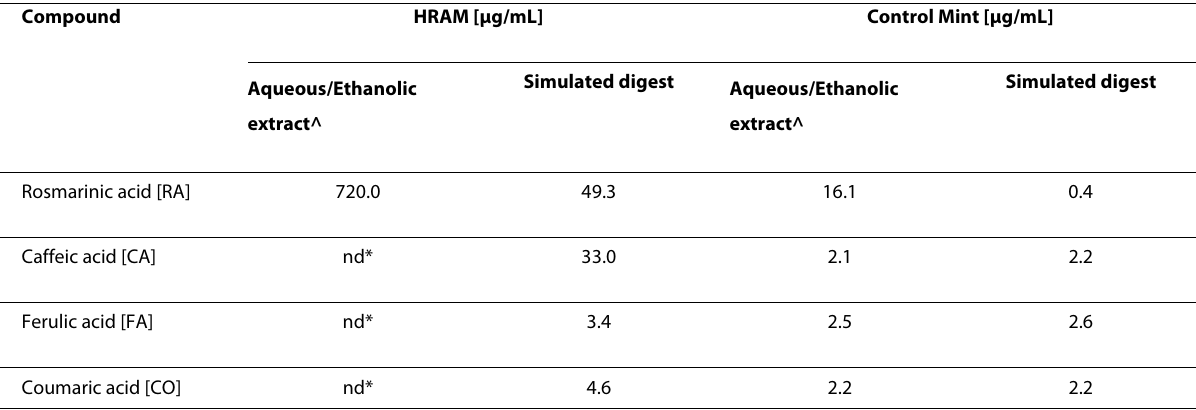
Table 1: Concentrations of metabolites identified in aqueous extract and simulated digest of HRAM and CM. Compound HRAM